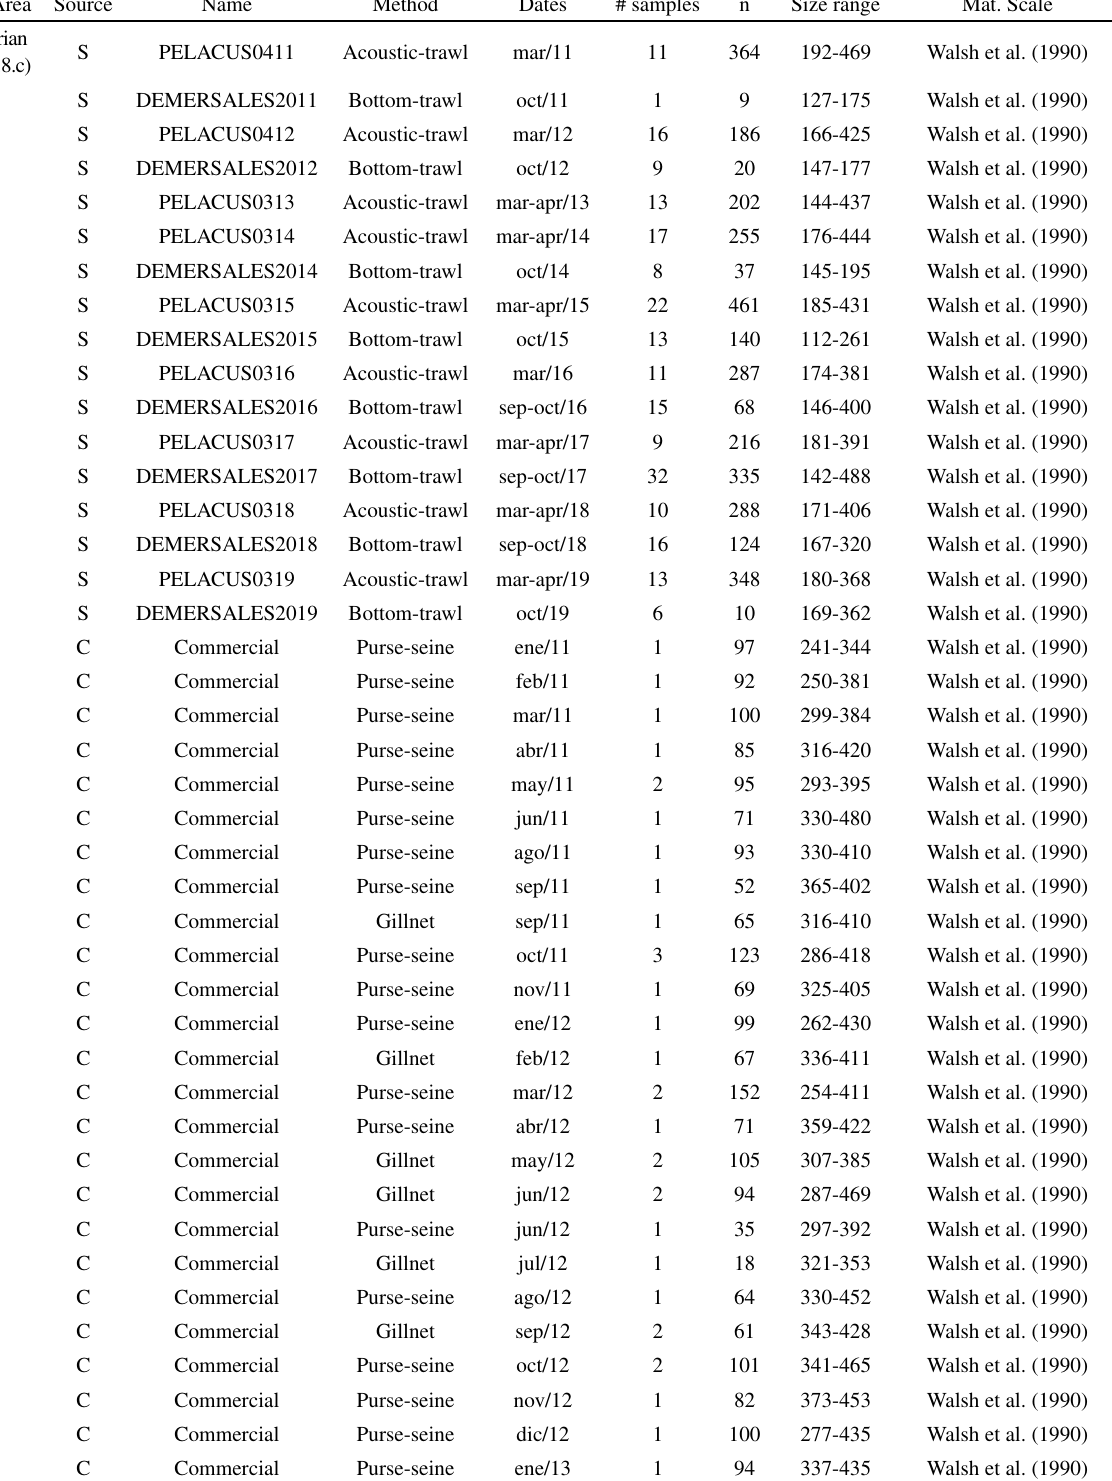
Table S1. – Detailed description of all samples considered in the present study, including study area (subdivision), sampling source (S, research cruise; C, commercial vessels), scientific survey name, survey methodology, sampling dates, number of samples (samples), number of individuals in each sample (n), size range of sampled specimens (cm), and maturity key used for macroscopic maturity staging (Mat. Scale). Attached as a separate PDF